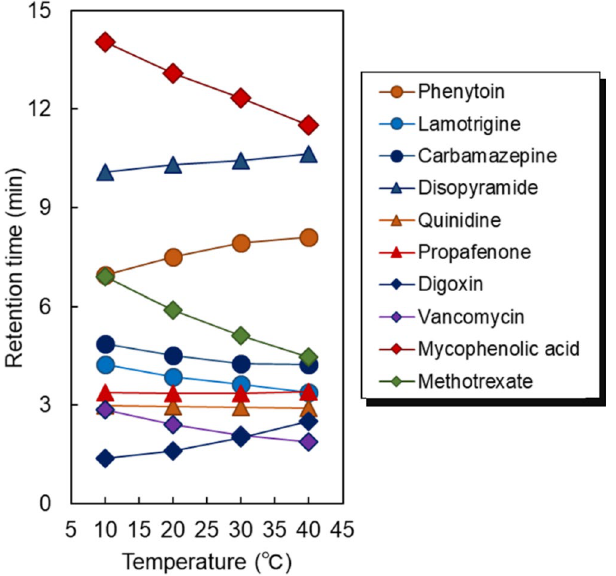
Figure 6. The retention time of drugs used in therapeutic drug monitoring using PNIPAAm hydrogel modified-bead columns. Retention times of mycophenolic acid and methotrexate were obtained using pH 4.80 CH 3 COONH 4 buffer solution as mobile phase. All other drugs used pH 6.75 CH 3 COONH 4 buffer solution mobile